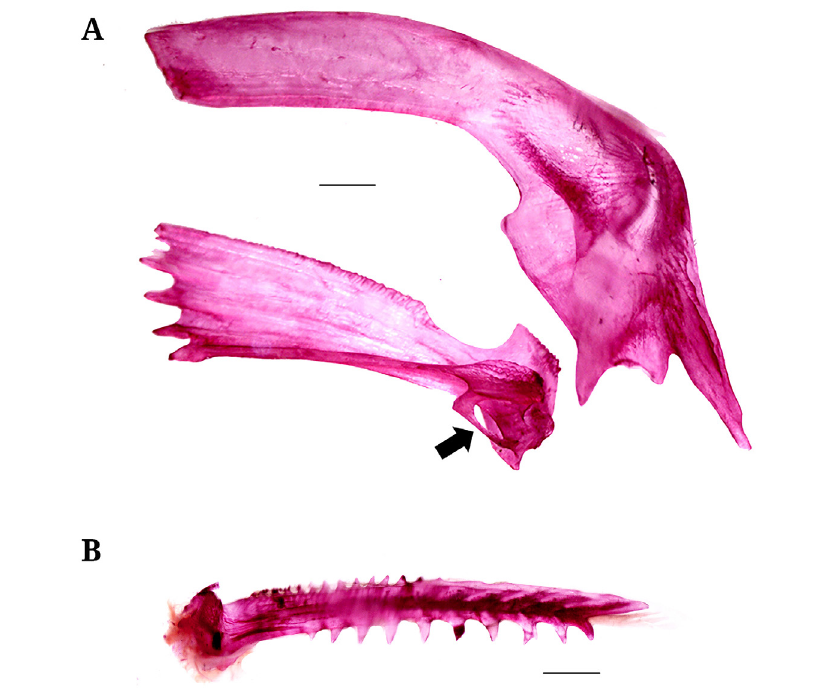
FIGURE 6 | Microglanis berbixae , MECN-DP 3762, paratype, 39.6 mm SL. A. Dorsal view right pectoral girdle. The arrow shows the filamentous mesocoracoid arch. B. Dorsal view right pectoral-fin spine. Scale bars = 1